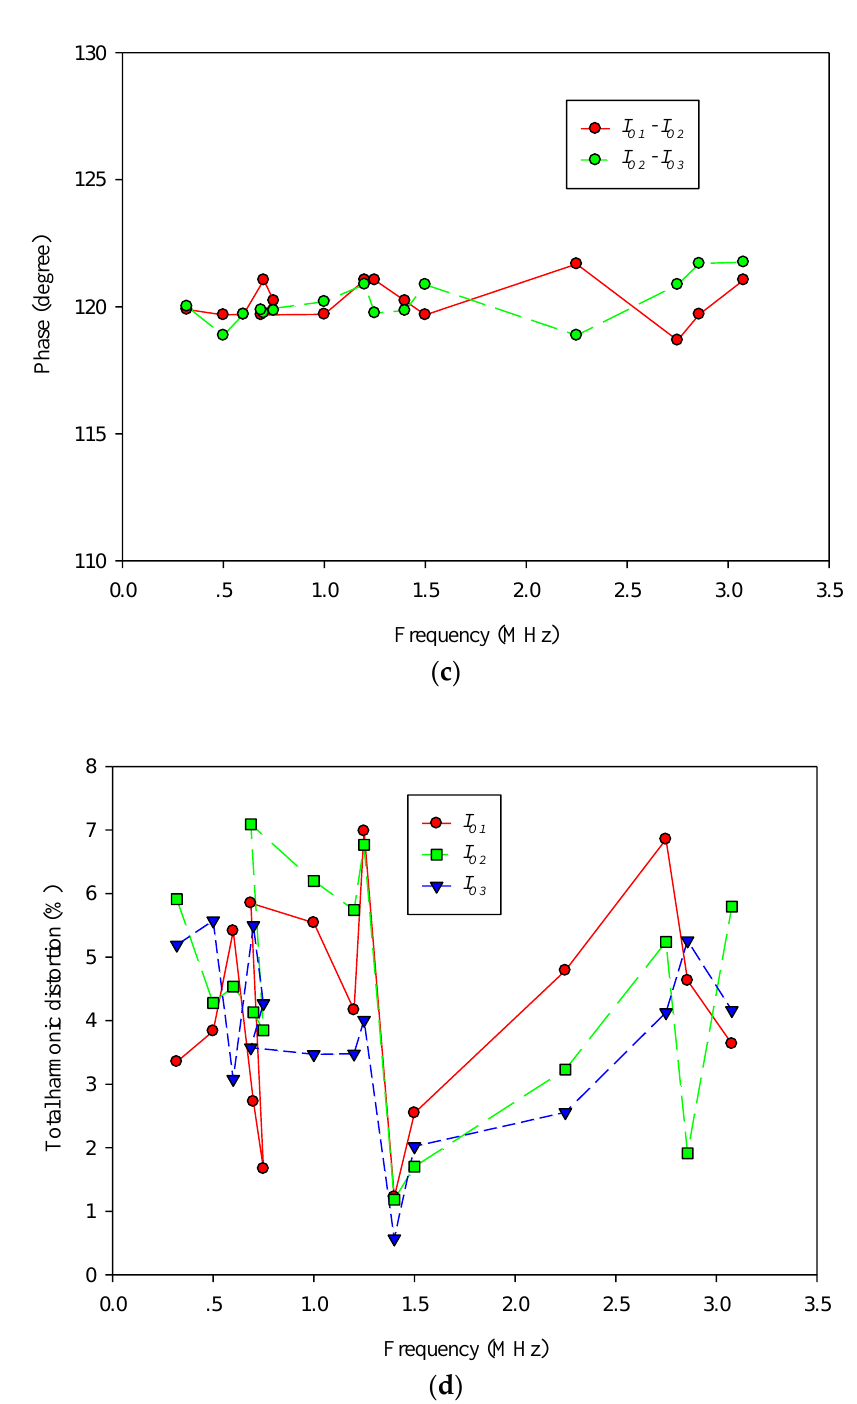
Figure 8. Simulated results of ( a ) FO by varying I B , ( b ) magnitude of current outputs, ( c ) phase difference of current outputs, ( d ) THD values of current outputs.